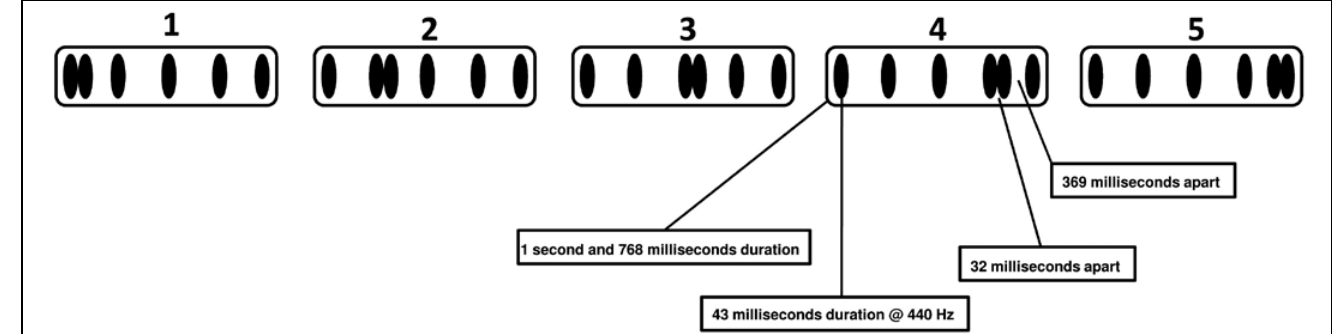
Fig. 1. Visual representation of short interpulse interval at position